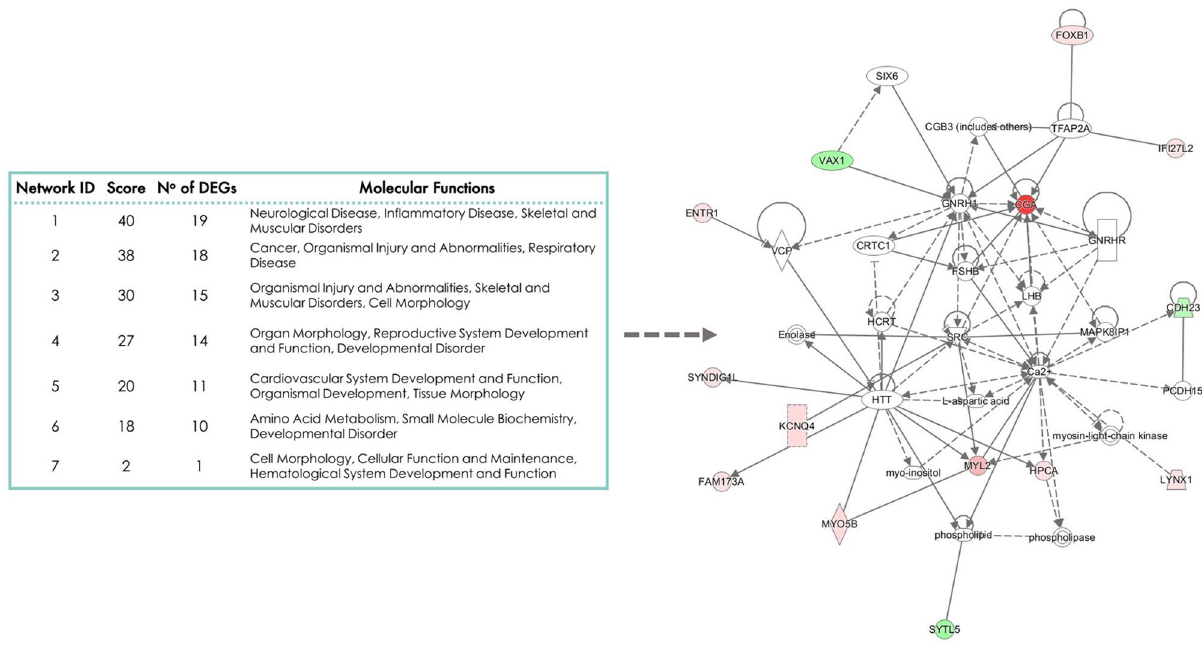
Figure 3. Networks derived from the list of differentially expressed genes (DEGs) in the arcuate nucleus (ARC) of prepubertal heifers on different planes of nutrition. Note that the higher the score the more connected the genes are. No of DEGs = number of DEGs from the input dataset included in the network. The arrow indicates Network 4: organ morphology, reproductive system development and function, developmental disorder derived from the list of DEGs in the ARC. Note that 14 of the DEGs in the ARC are included in this network (downregulated in green and upregulated in